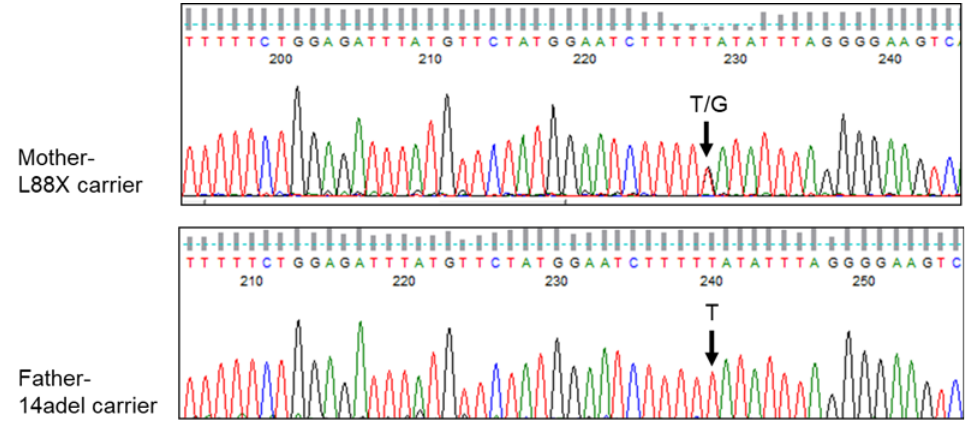
Figure 5. Primary nasal epithelial cells of heterozygous carrier of L88X generate detectable L88X- CFTR mRNA. Top panel. Sanger sequencing of RT-PCR of region surrounding L88X. Total RNA was extracted from conditionally reprogrammed primary human nasal epithelial (NE) cells from mother of the proband, who is a carrier for L88X. RT-PCRs were performed using CFTR -specific primers to amplify the L88X region. Bottom panel. Sanger sequencing of RT-PCR of region surrounding L88X. Total RNA was extracted from conditionally reprogrammed primary human nasal epithelial (NE) cells from the father of the proband, who is a carrier for 14adel. RT-PCRs were performed using CFTR -specific primers to amplify the L88X region.